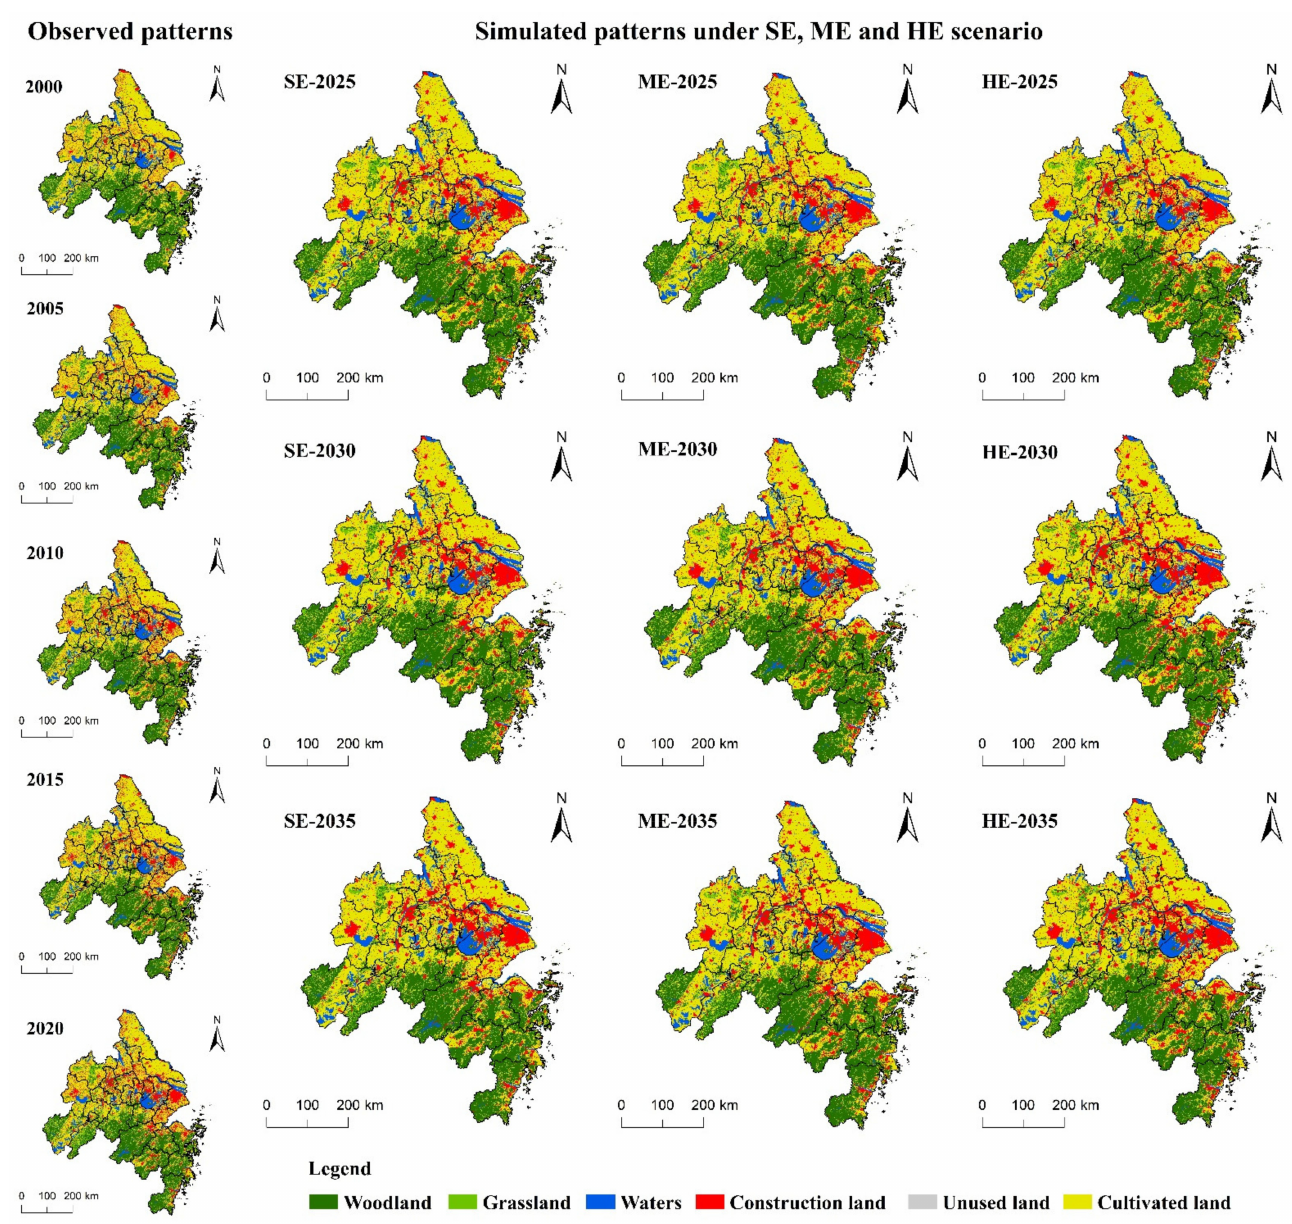
Figure 6. Land-use and -cover change in YRD from 2000 to